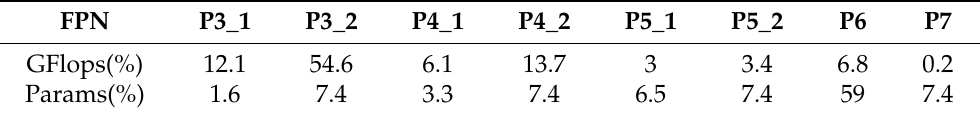
Table 3. The distribution of the computation amount (GFlops) and parameter amount (Params) of FPN.